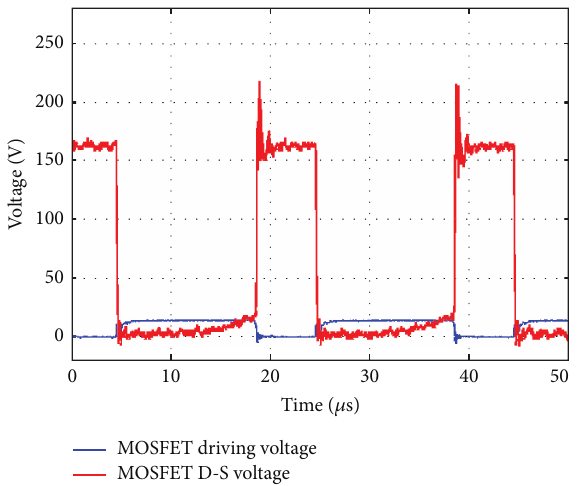
Figure 16: The Buck converter with RCD absorption